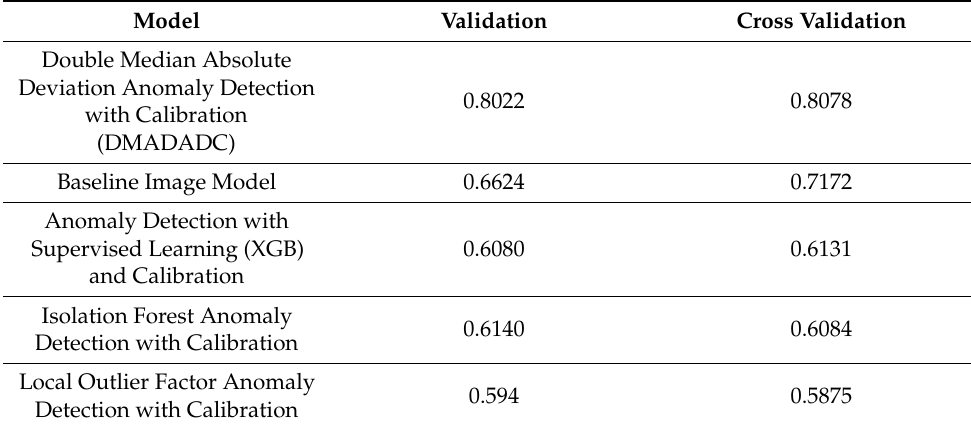
Table 3. Unsupervised models for best model anomaly detection.